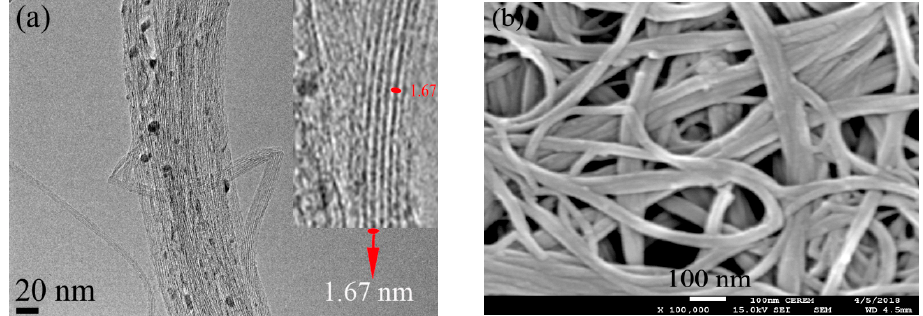
Figure 2. Images of single-walled carbon nanotubes before irradiations. ( a ) High resolution TEM image and ( b ) SEM image of SWCNTs.